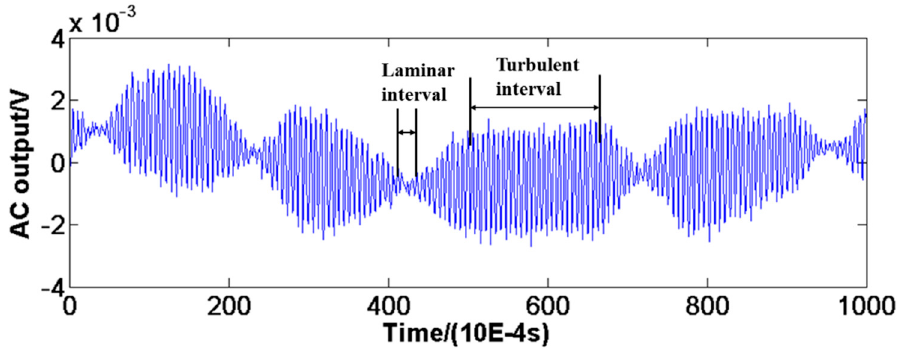
Figure 14. An AC output voltage-versus-time trace of sensor 2 at U = 0.28 m/s.